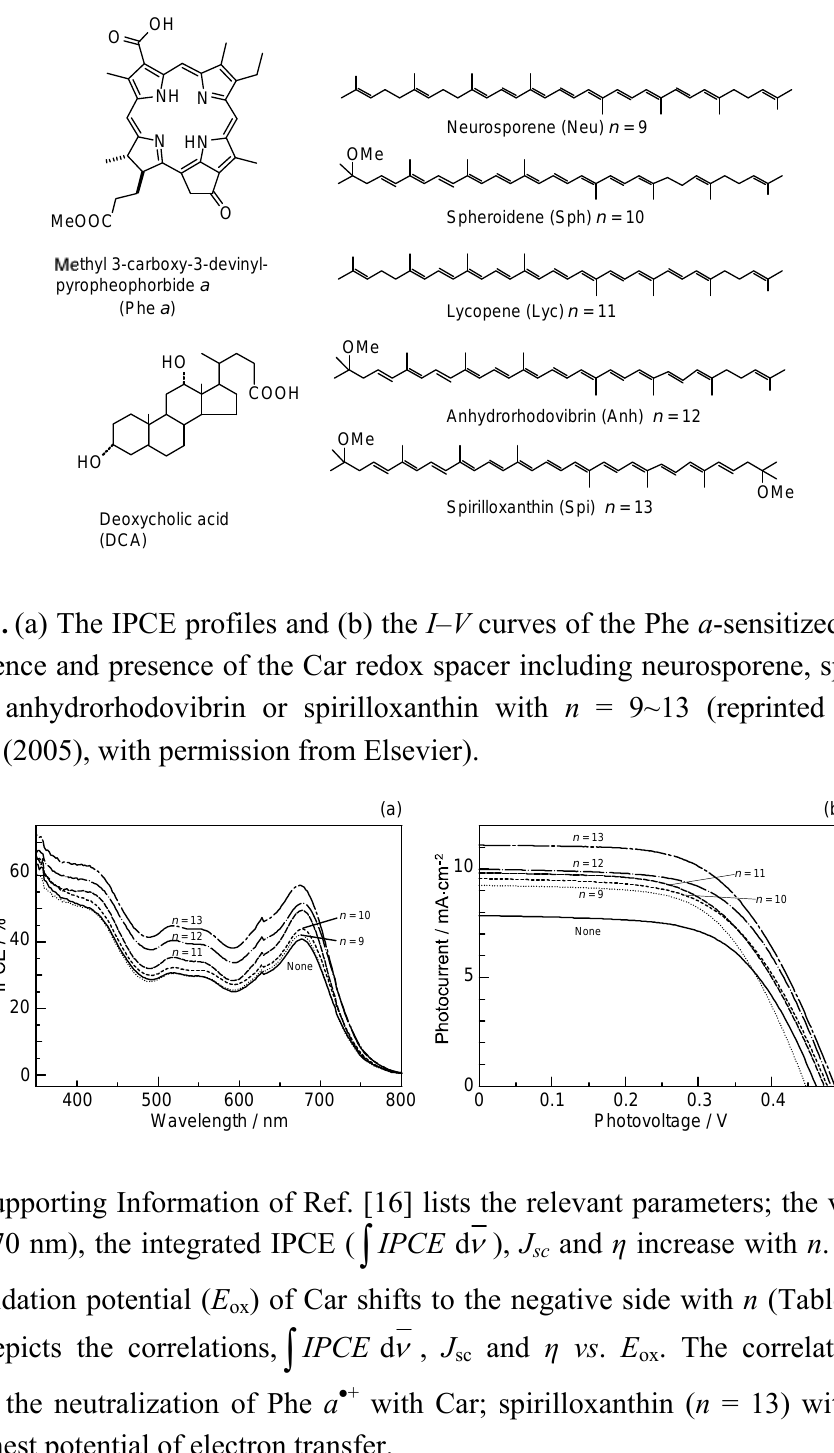
Figure 18. Chemical structures of the Phe a sensitizer and the spacers including DCA and a set of bacterial Cars with n = 9~13 (reprinted from [16], Copyright (2005), with permission from Elsevier).